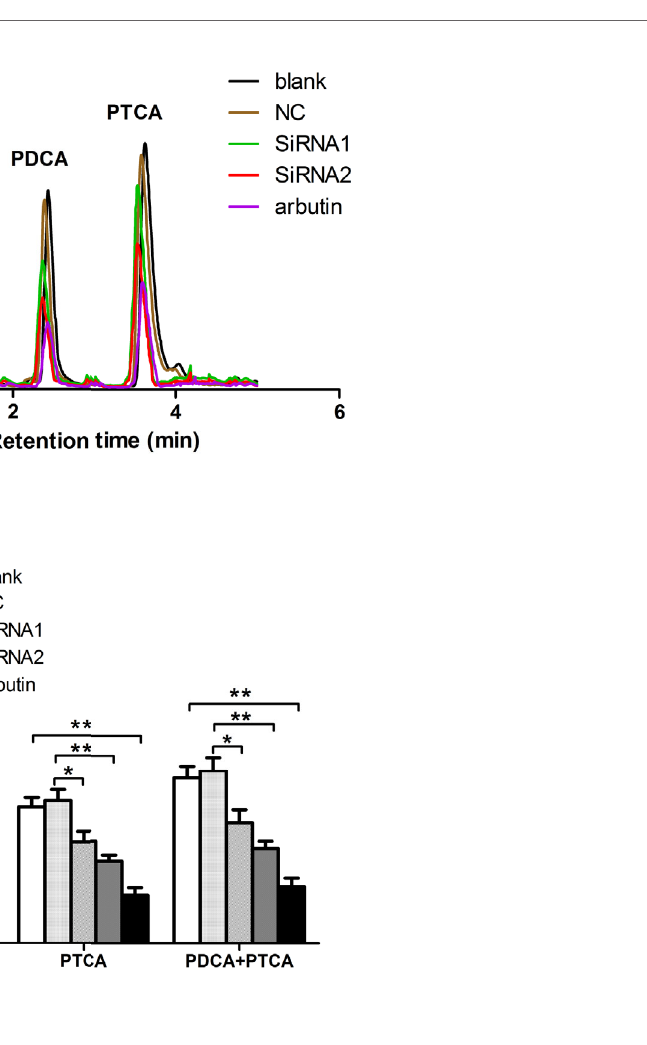
FIGURE 5 | The content of melanin from samples in blank, NC, RNAi groups and arbutin group using LC-MS/MS analysis. (A) HPLC (High Performance Liquid Chromatography) chromatograms. (B) The content of PDCA and PTCA. The data were represented as the mean ± SD ( N = 5). * P < 0.05; ** P <